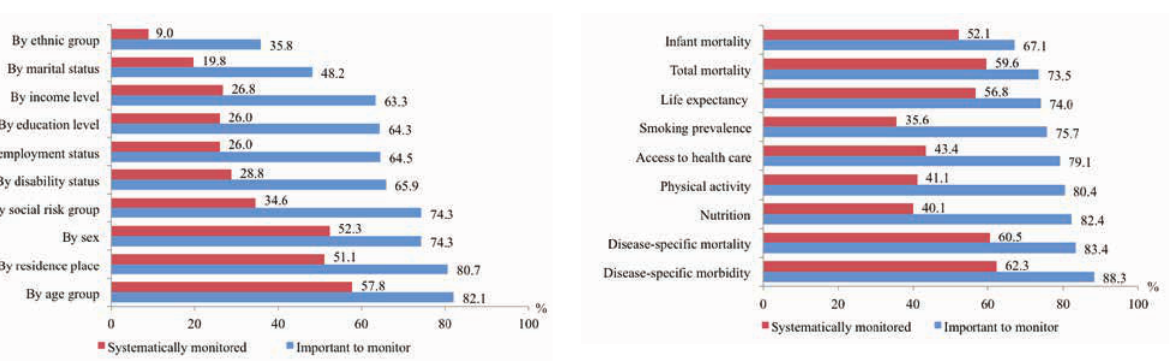
Figure 1: Respondents’ attitudes towards monitoring sociodemogra- phic health inequalities at the municipal level